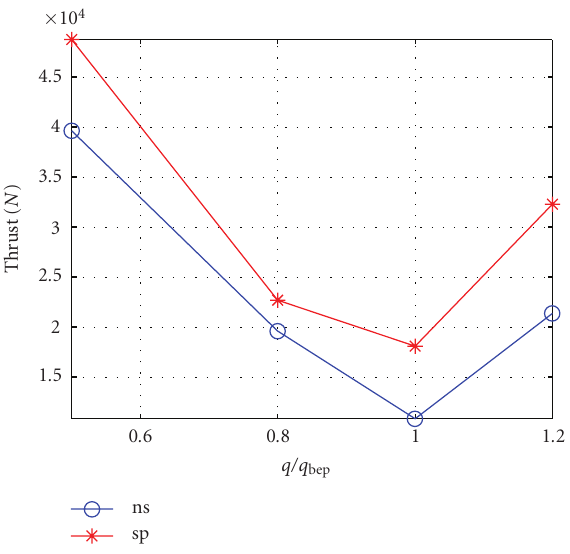
Figure 14: Amplitude of the radial thrust at di ff erent flow